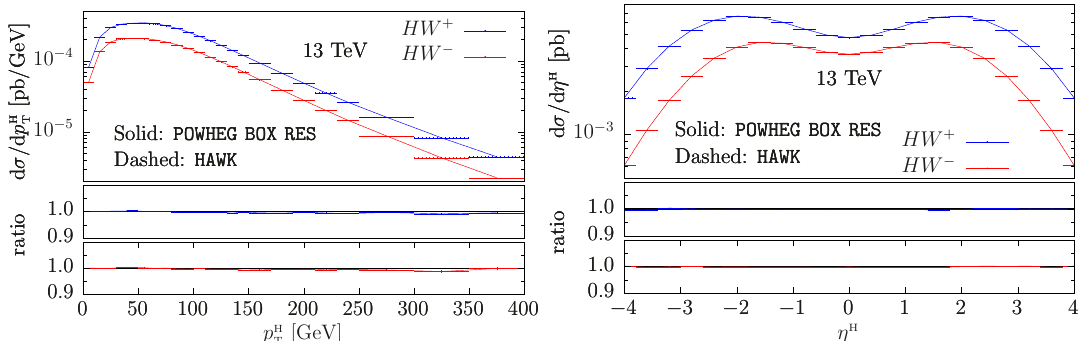
Figure 28. NLO EW predictions for the transverse momentum (left) and the pseudorapidity (right) of the Higgs boson in HW (cid:6) production. The POWHEG BOX RES and HAWK results are shown with solid and dashed lines respectively. The vertical bars (hardly visible) represent the statistical uncertainties associated to the Monte Carlo